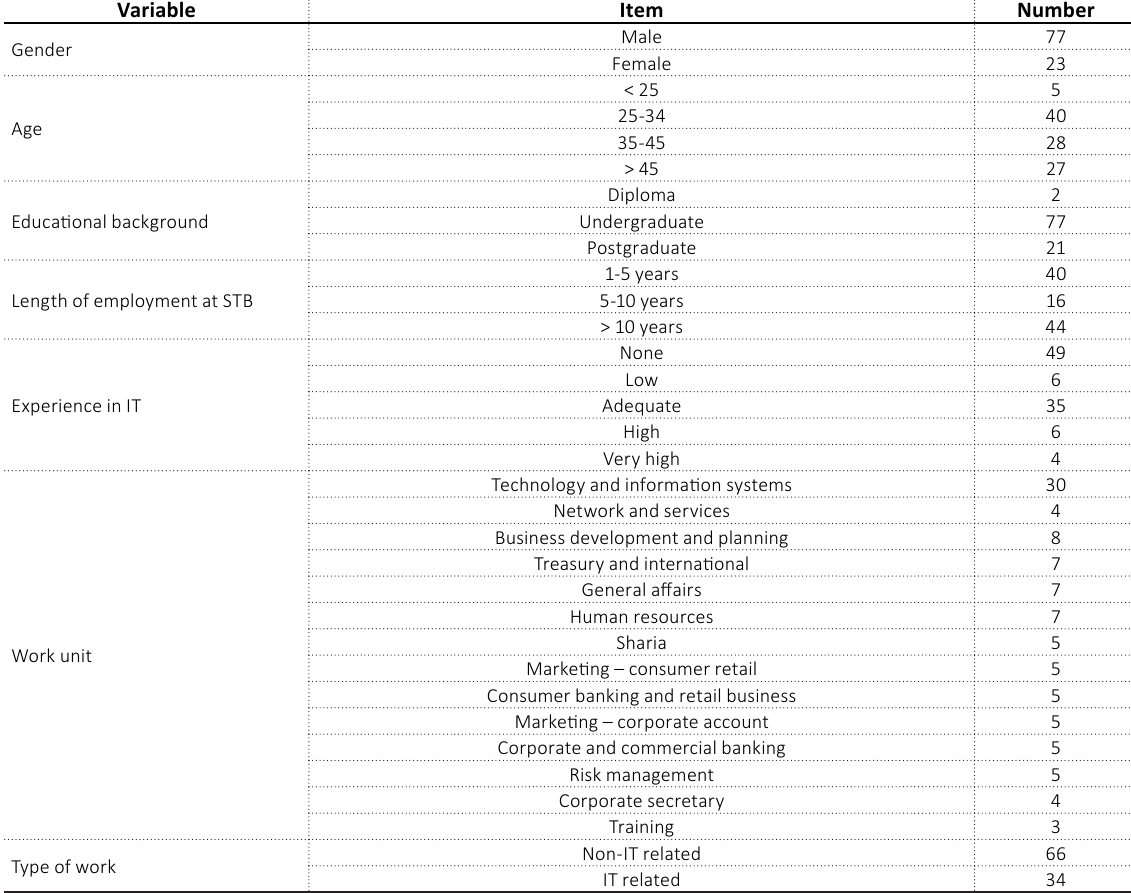
Table 10. Descriptive information of STB internal